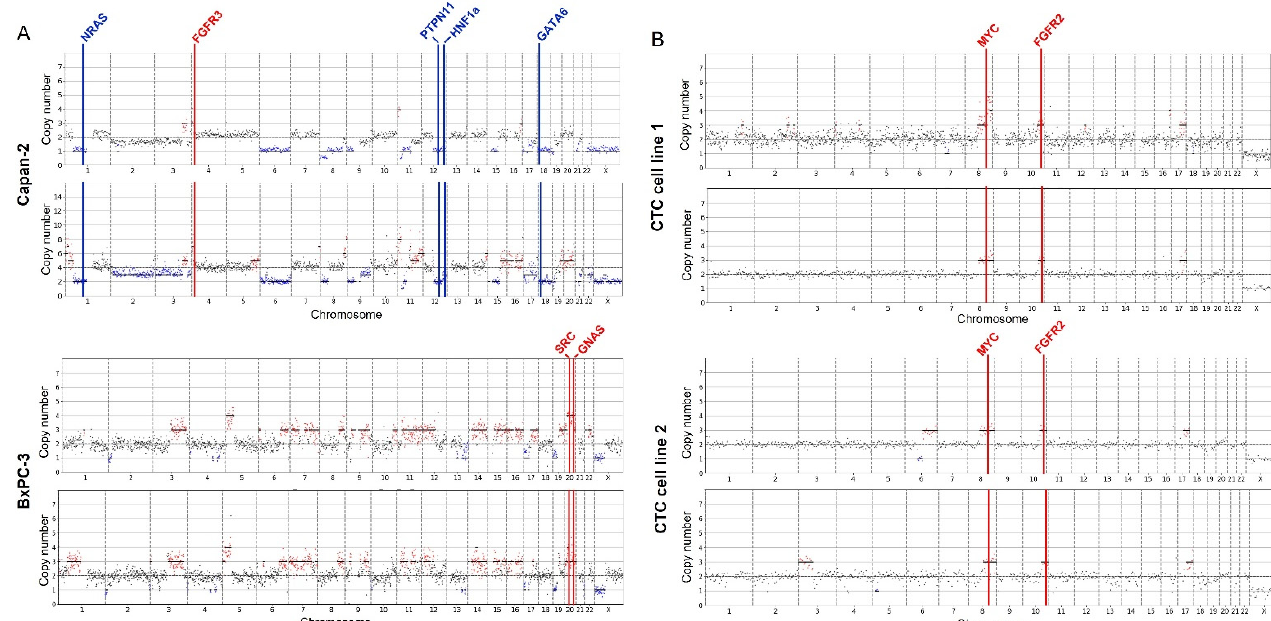
Figure 3. Single-cell copy number variation profiles from established pancreatic cancer cell lines and pancreatic-cancer-patient-derived CTC cell lines. Each graph represents an individual cell. Regions and genes highlighted in red experienced gains while regions and genes in blue experienced losses. Regions in black are neutral and center around the ploidy. Specific genes highlighted appeared across all individual cells (n = 2) of the same cell line and have been noted in reference datasets for established cell lines. Cell lines are as follows: ( A ) Capan-2, BxPC-3, ( B ) CTC cell line 1, CTC cell line 2.